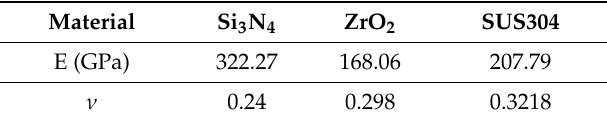
Table 3. Properties of materials.